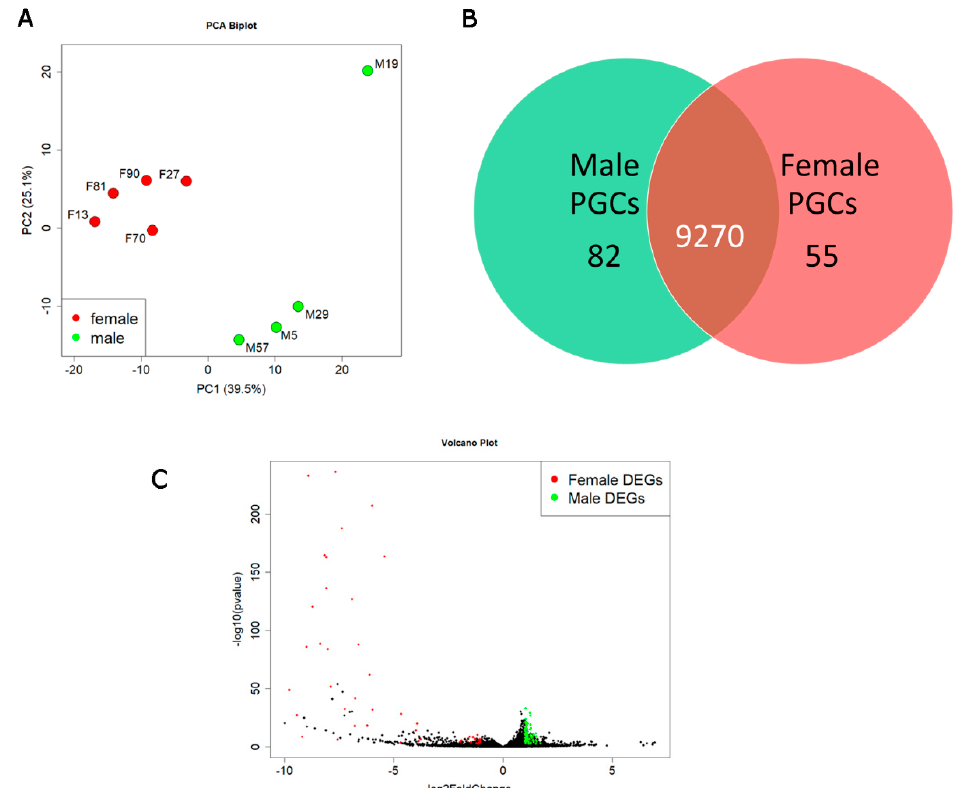
Figure 3. The transcriptome comparison between male and female PGCs. ( A ) PCA plot depicting the clustering of male and female chicken PGCs based on the top 1000 variable genes between male and female PGCs. ( B ) A Venn diagram showing the number of genes expressed in male and female chicken PGCs. Genes with an average normalized read count higher than 500 were considered to be expressed in a particular cell type. ( C ) The volcano plot shows the di ff erentially expressed genes. The green and red colored dots indicate the genes that have an absolute log2fold change > 1 with an adjusted p -value < 0.05 and an average expression value higher than 500 in male and female PGCs, respectively ( C ).